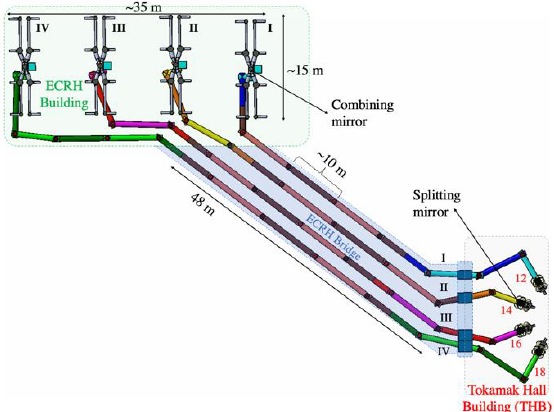
Fig. 3. Top view of TLs, including the SBTL in the ECRH building (top left), the MBTL along the bridge (centre) and the penetrations in the THB with the connections to the DTT dedicated sectors (bottom right).